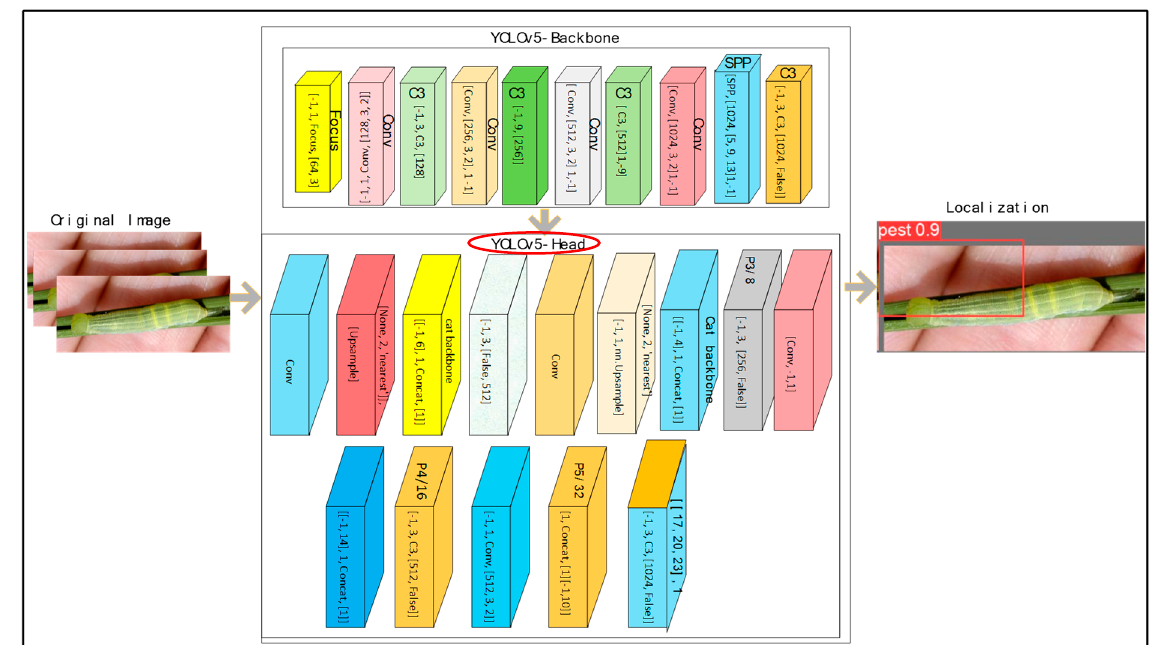
Figure 2. Proposed YOLOv5 model for localization. Table 1. Parameters of YOLOv5